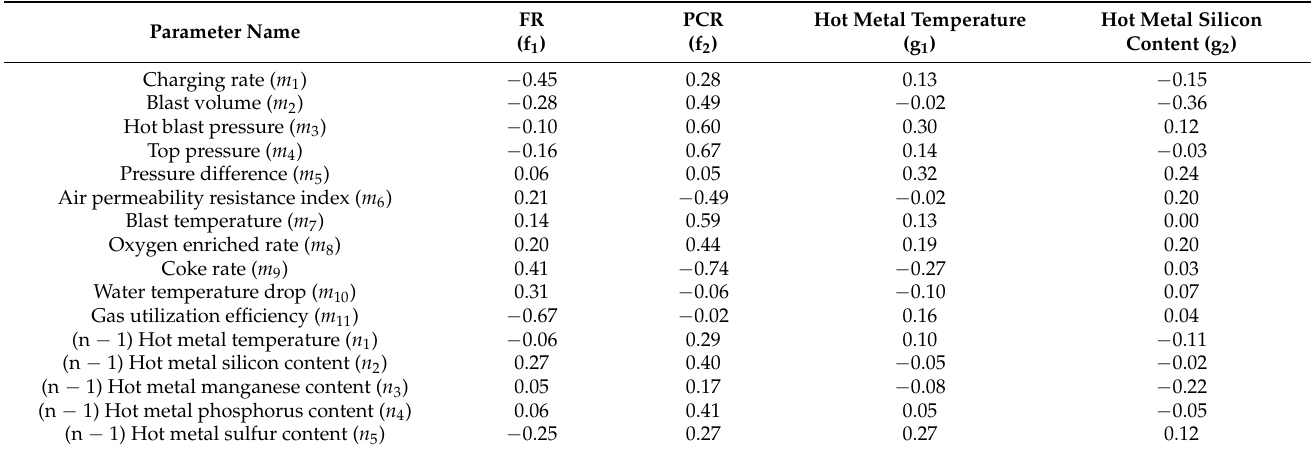
Table 1. Spearman’s rank correlation